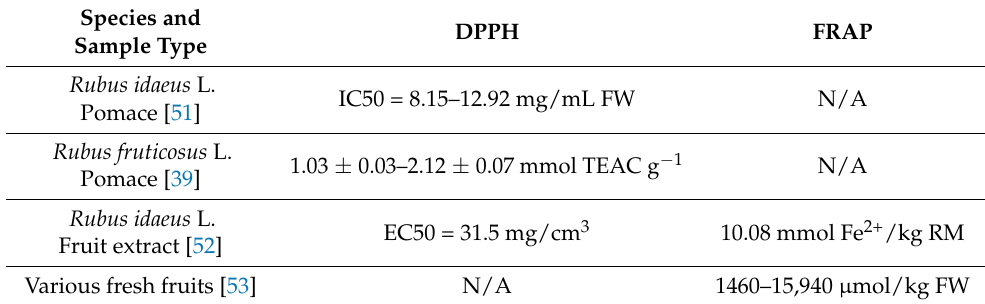
Table 3. Antioxidant activity of raspberry fruit pomace. DPPH FRAP Type of ( µ mol/L) Extraction UAE 1002.72 ± 12.20 CM 772.73 ± 10.50 361.27 ± 5.65 Values represent mean ± SD of three measurements ( n = 3). Table 4. DPPH and FRAP values from the literature. Species and DPPH FRAP Sample Type Rubus idaeus